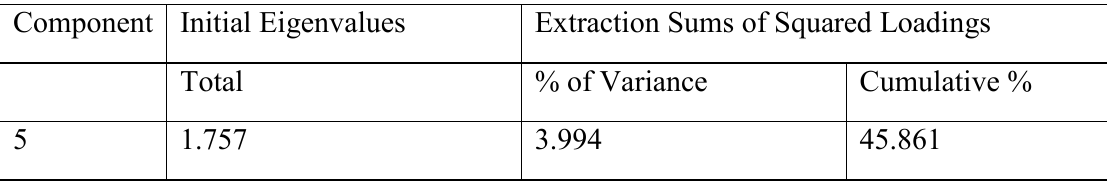
Table 1.9: Variance explained for Absorptive Resilience PC5